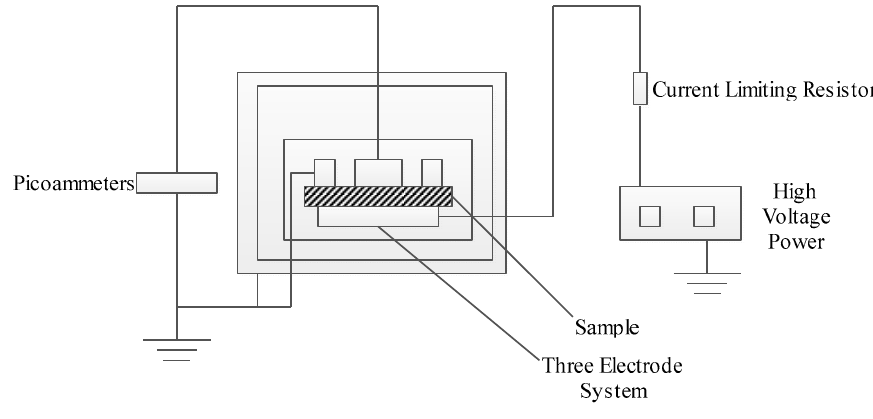
Figure 1. Conductance current test device.